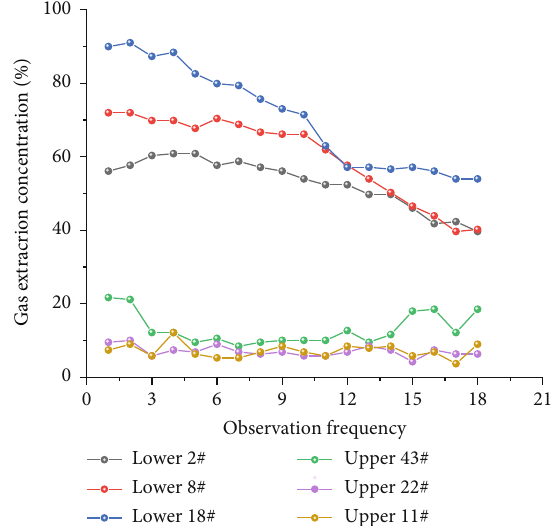
Figure 15: Extracted gas concentration before and after implementing hydraulic fracturing